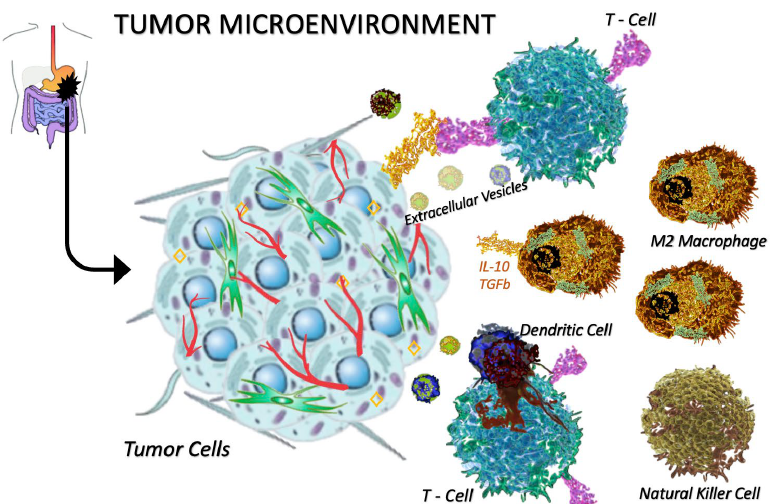
Figure 1. The tumor microenvironment population in cancer. The tumor microenvironment (TME) is populated by several immune cell types. In this figure, the following are represented: T-cells, M2 macrophages, dendritic cells, and natural killer cells. The M2 macrophages are characterized by their high expression of cytokines such as IL-10 and TGFb; thanks to these cytokines, the M2 macrophages promote an immunosuppressive environment.